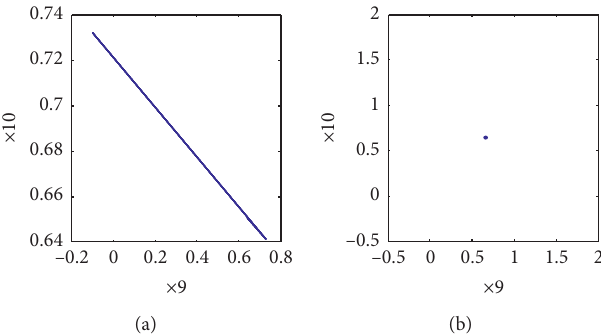
Figure 14: ω � 110 and k � 0 . 248 without random perturbation. (a) Phase trajectories. (b) Poincare w